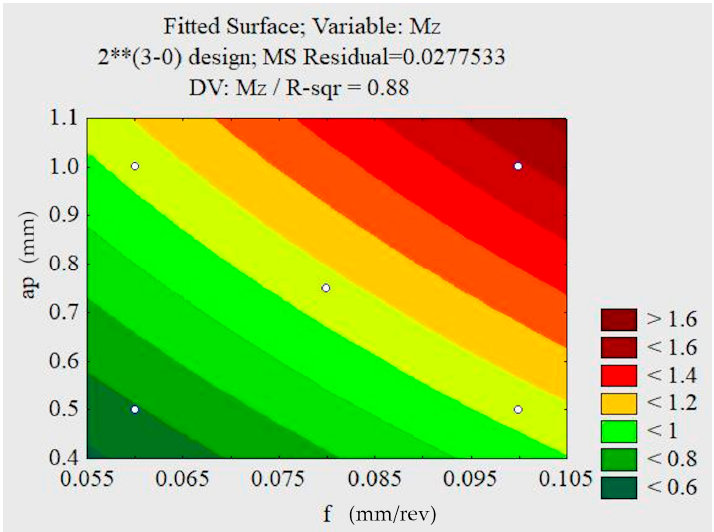
Figure 13. Response surfaces for the non-lubricated condition (M z ).